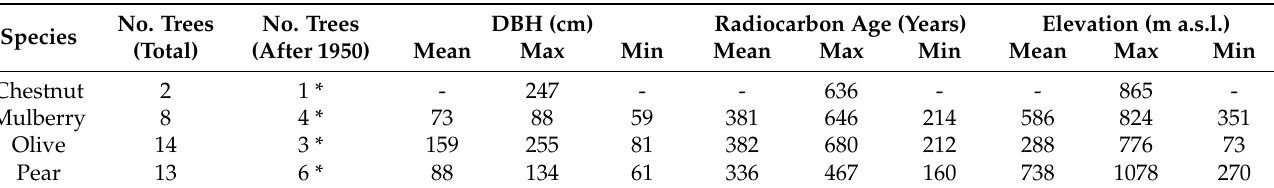
Table 3. Statistics of fruit trees analyzed through radiocarbon analyses. Modern radiocarbon dates (asterisks) were not included in the results.